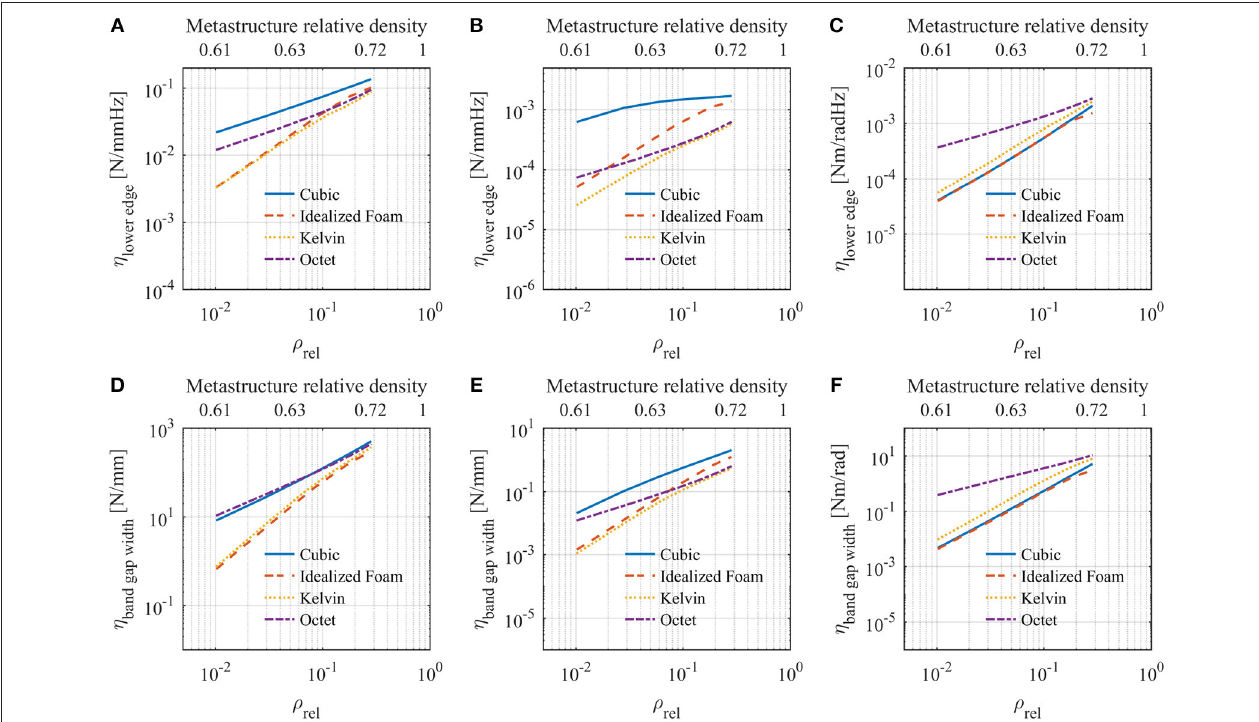
FIGURE 9 | Multifunctional performance parameters for all polarizations. (A) Axial η lower edge . (B) Bending η lower edge . (C) Torsional η lower edge . (D) Axial η band gap width . (E) Bending η band gap width . (F) Torsional η band gap width .Metastructure relative densities are shown for